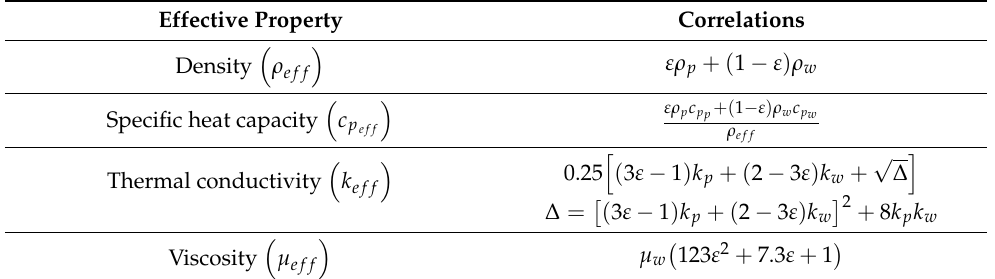
Table 3. The correlations to calculate the thermophysical properties of nanofluid [39,42,43]. Effective